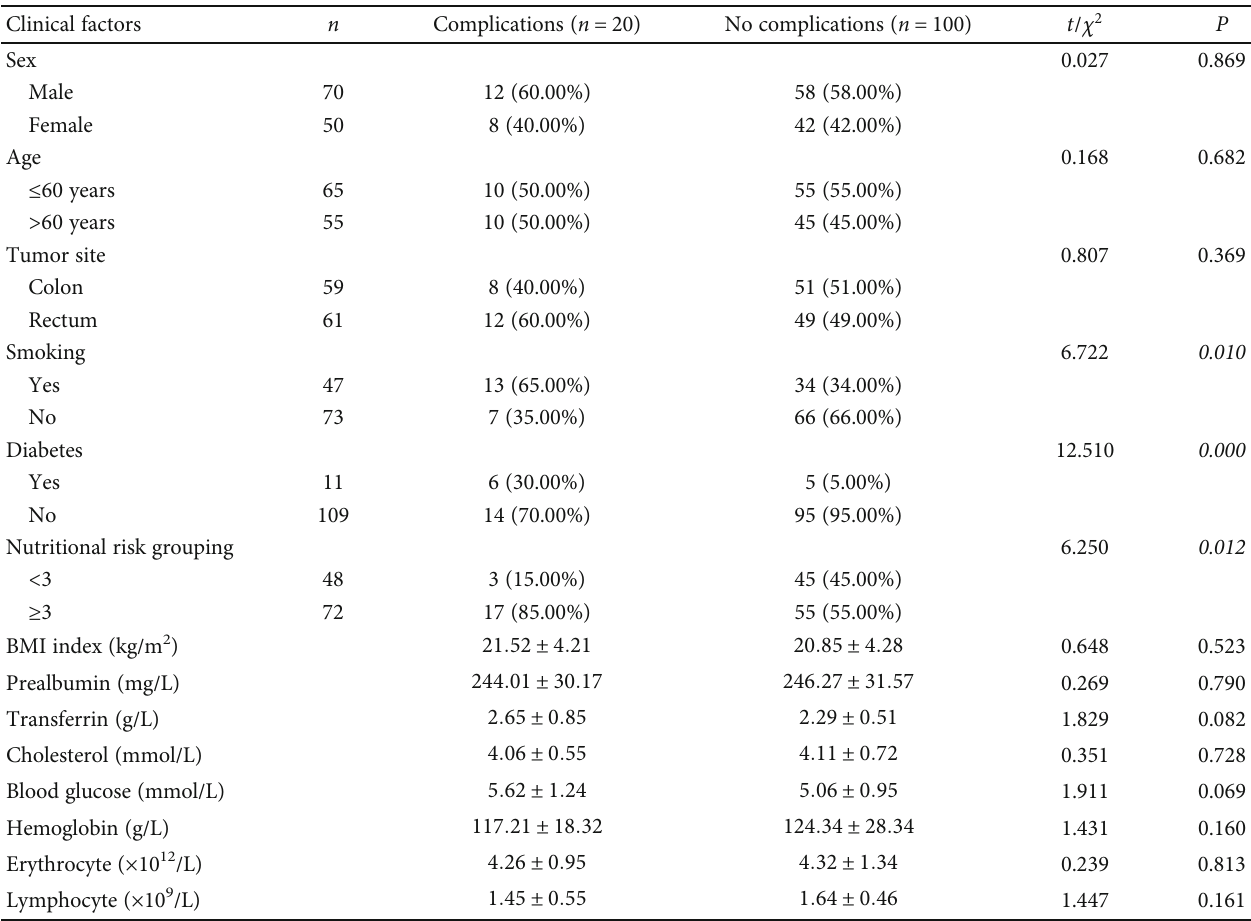
Table 4: Univariate analysis of postoperative